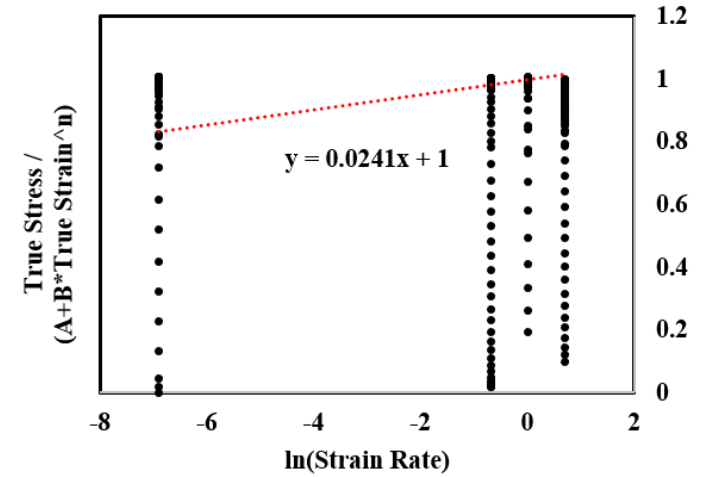
. ∗ ε and ln for four different strain rates (0.001 s − 1 , 0.5 s − 1 , and 𝑙𝑛𝜀(cid:4662) ∗ for four different strain rates (0.001 s − 1 , 0.5 s − 1 , 1 ( A + B ε ) n ((cid:3002)(cid:2878)(cid:3003)(cid:3084)) (cid:3289)